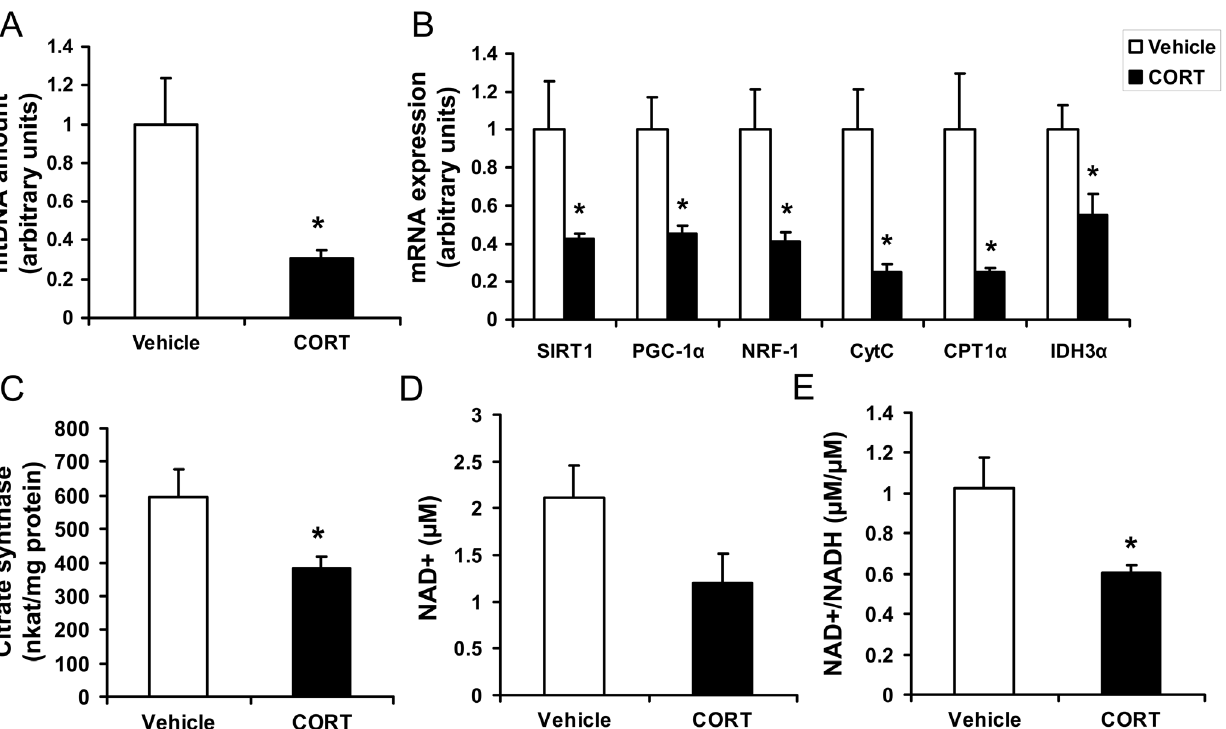
Figure 4. Effect of CORT on mitochondrial biogenesis and function in epididymal WAT of mice. ( A ) Relative abundance of mitochondrial DNA (mtDNA), ( B ) relative mRNA levels of mitochondrial genes responsible for mitochondrial biogenesis and function, ( C ) activity of citrate synthase (CS), ( D ) NAD + levels, and ( E ) NAD + /NADH ratio in epididymal white adipose tissue (WAT) of mice treated with 100 m g/ml CORT or vehicle for 4 weeks. Data are expressed as group means 6 SEM (n=6 by group). All the mRNA expression data are normalized to the house keeping gene (18S rRNA), mtDNA is the relative amount to genomic DNA * P , 0.05 compared with vehicle.